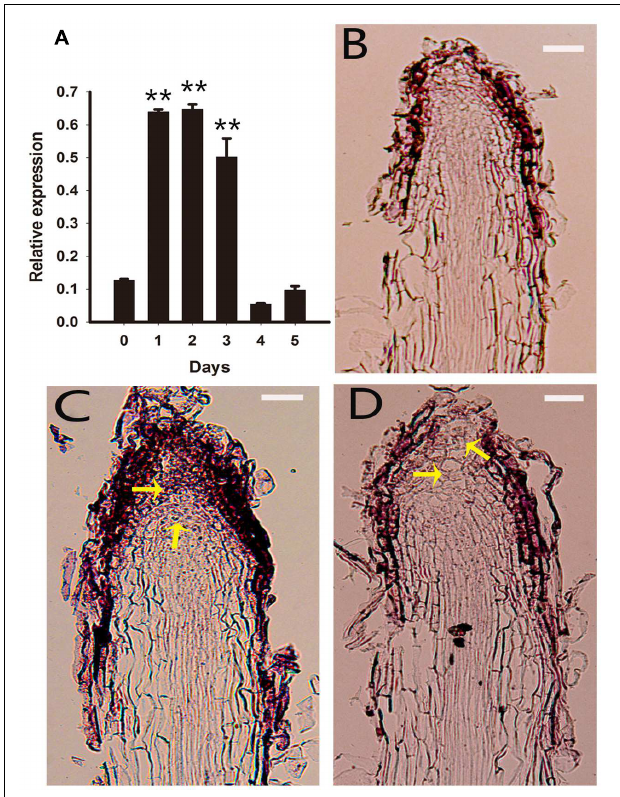
FIGURE 6 | Expression pattern of RcPLT1 in rhizoid tips. Rhizoid tips were collected after culture on PIM for 0, 1, 2, 3, 4, and 5 days. (A) Quantitative real-time PCR analysis of RcPLT1 expression pattern during the first 5 days of PLB formation. Error bars represent the SE of three biological replicates. Asterisks indicate highly significant differences calculated using the t test ( ∗∗ P < 0.01) ( n = 3 for each treatment). (B–D) In situ hybridization in longitudinal sections of rhizoids. RcPLT1 expression in rhizoid tips (B) before culture on PIM, (C) after culture for 3 days, or (D) after culture for 9 days. Yellow arrows show the position of RcPLT1 expression. Bars = 2 µ